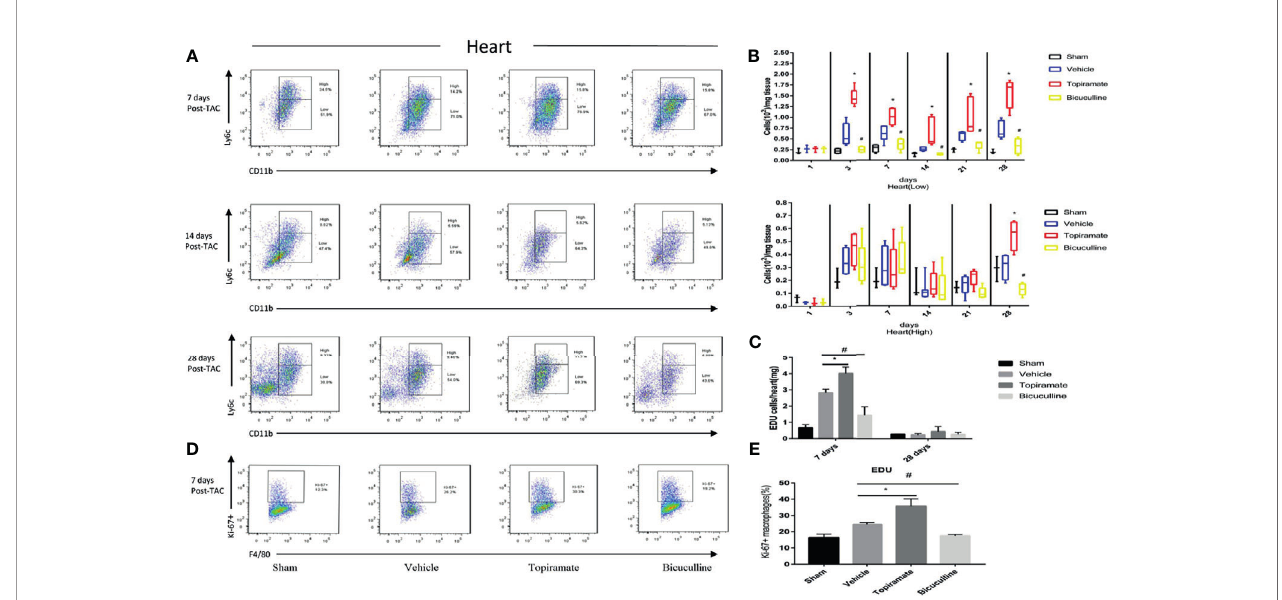
FIGURE 3 | Activation or blockade of the GABA A receptor selectively increases or reduces the number of Ly6C low macrophages in the hearts of pressure-overload hypertrophy mice. Macrophage (CD45 + F4/80 + CD11b + ) subpopulations were respectively de fi ned as Ly6C high or Ly6C low macrophages according to Ly-6C expression levels. (A) Representative images of Ly6C high and Ly6C low macrophages at days 7, 14, and 28 post-TAC. The representative images of 1, 3, and 21 days after TAC were shown in supplementary materials. (B) The number of Ly6C low macrophages or Ly6C high macrophages (per mg heart tissue) among the total number of live cells isolated from hearts at the indicated time points after TAC. (C) The number of CD45 + CD11b + F4/80 + EdU + cell (per mg heart tissue) among the total number of live cells isolated from hearts at the indicated time points after TAC. (D) Representative images of Ki-67 + expression in Ly6C low macrophages at day 7 post-TAC. (E) The percentage of Ki-67 + expression in Ly6C low macrophages. Data show the mean ± SEM, by one-way ANOVA with Bonferroni ’ s multiple comparison test. For topiramate treatment, *P < 0.05 vs . vehicle. For bicuculline treatment, # P < 0.05 vs. vehicle. (n = 3 mice for sham group, n = 6 – 8 mice for all other